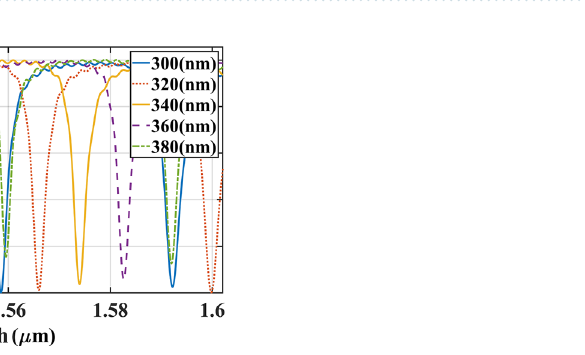
Figure 5. The transmission spectrum of ICCRR in terms of width of the outer ring WSi_out . The circular rings with a gap size of 180 nm used for simulation.